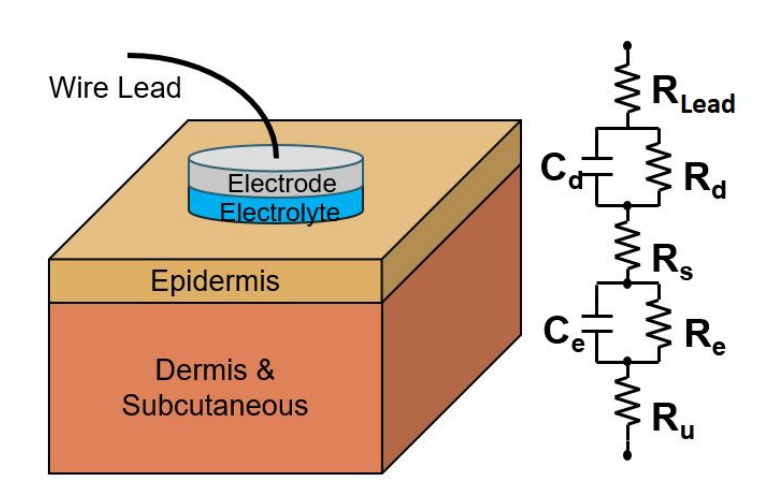
Figure 5. Traditional Double Time Model of the skin − electrode interface [9,14,18].